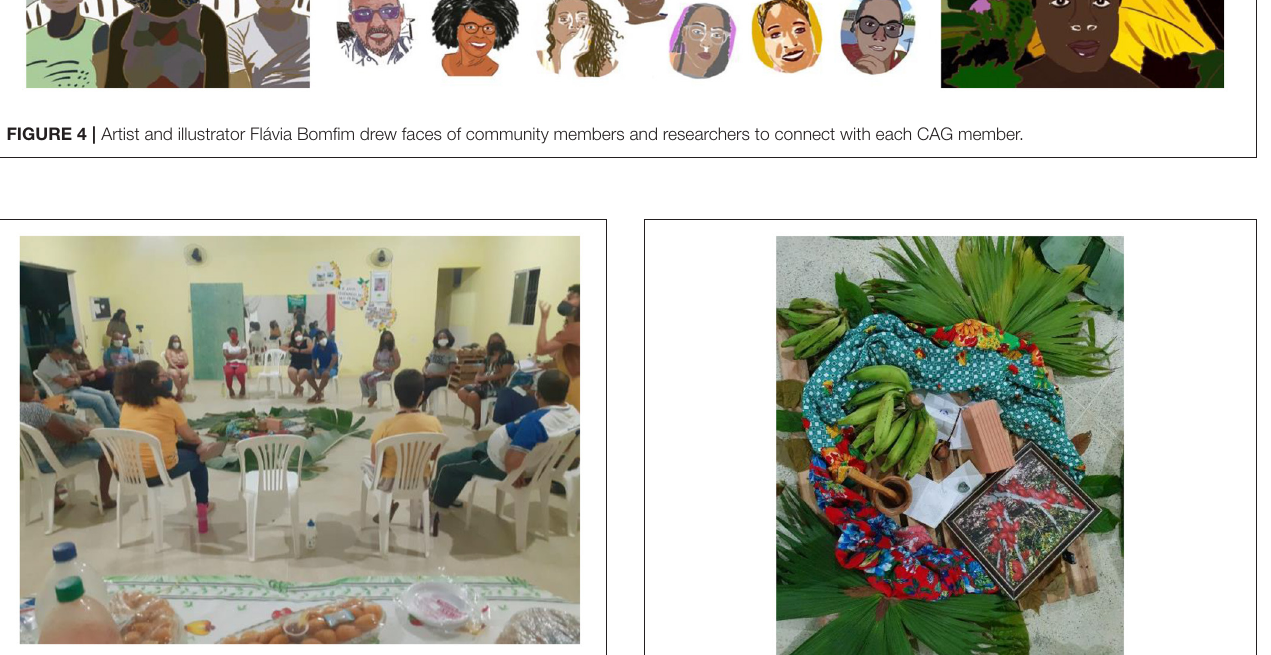
FIGURE 6 | A mandala created by Brazil CAG members representing their community.